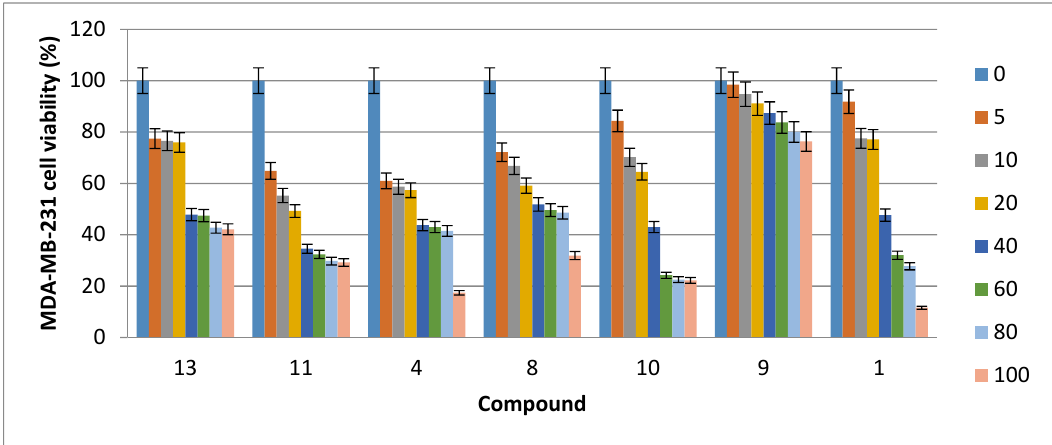
Figure 4. Anti-proliferative activities of compounds against human breast cancer MDA-MB-231 cells. The MTT assay was performed three independent times ( n = 3) using different concentrations of the mentioned compounds.